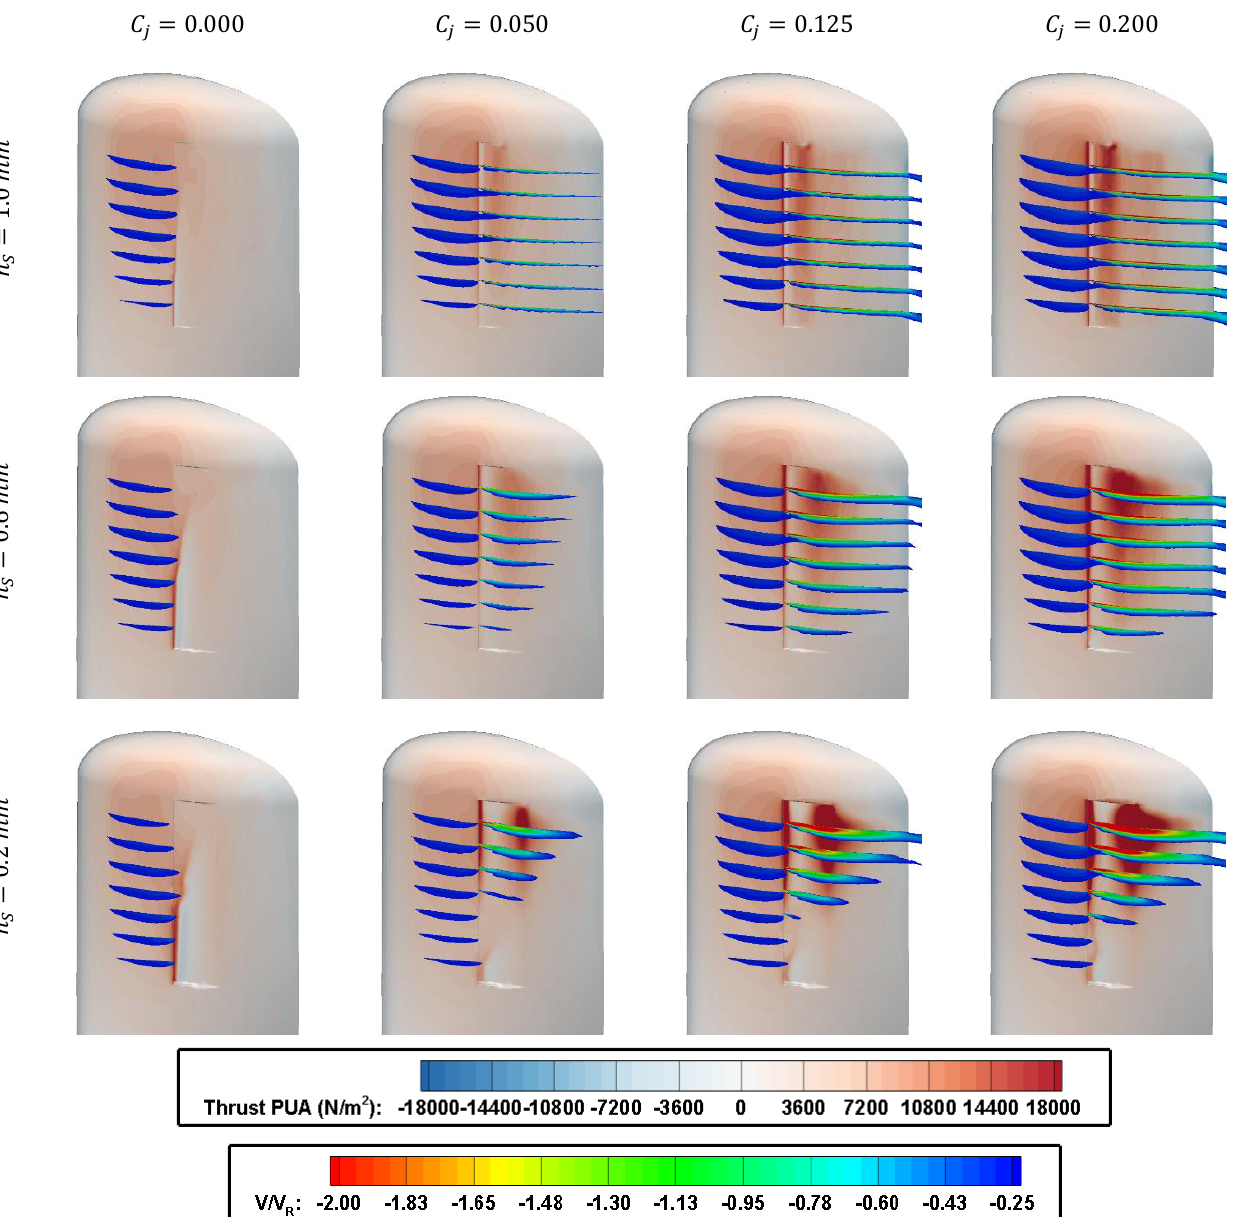
Figure 15. Distribution of tangential velocity and thrust PUA according to C j for each slit height ( J A = 0.4)